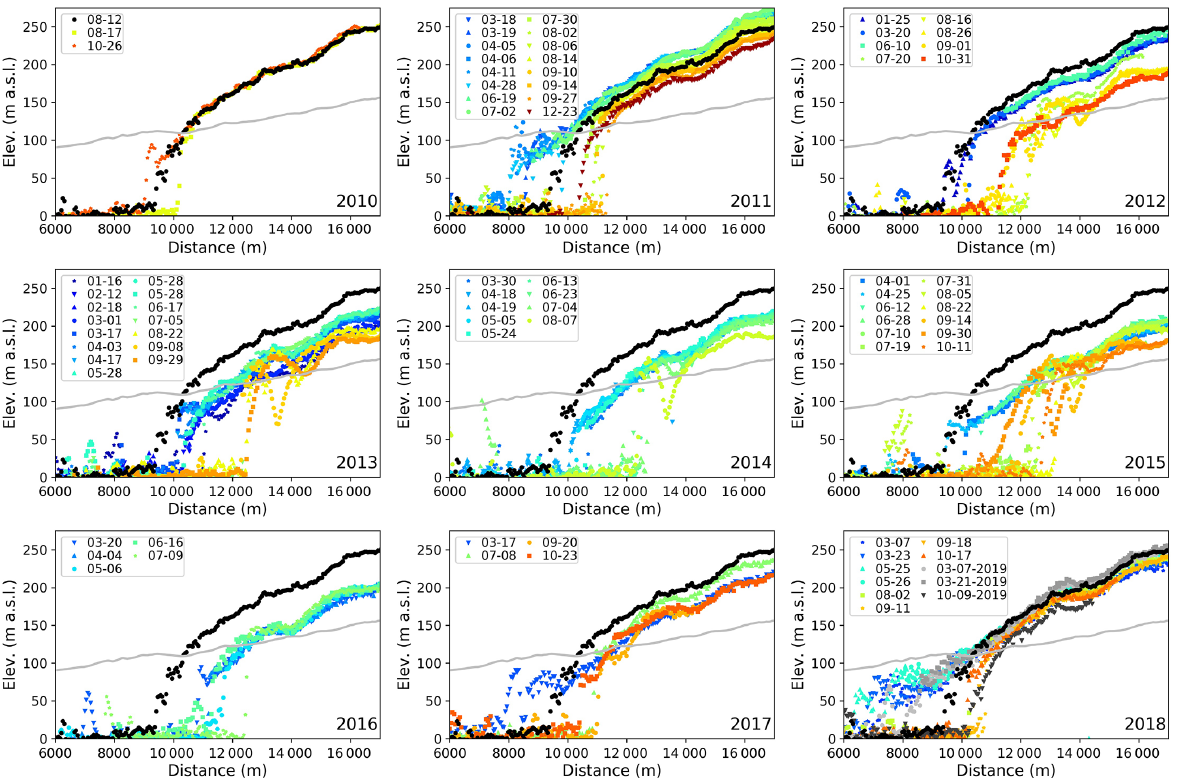
Figure 3. Plots for each year from 2010 through 2018 showing the available near-terminus elevation profiles, with three 2019 profiles included in the 2018 plot (see Fig. S2 for separate 2018 and 2019 plots). Profiles are labelled by date (MM-DD), and the profile location is shown in Fig. 1. For reference, the initial 2010 profile (12 August 2010) is included in each plot. All elevations are relative to nominal mean sea level (EGM2008 geoid). The grey line indicates the flotation height as estimated using bed elevations (Fig. S1) from BedMachine v3 (Morlighem et al.,